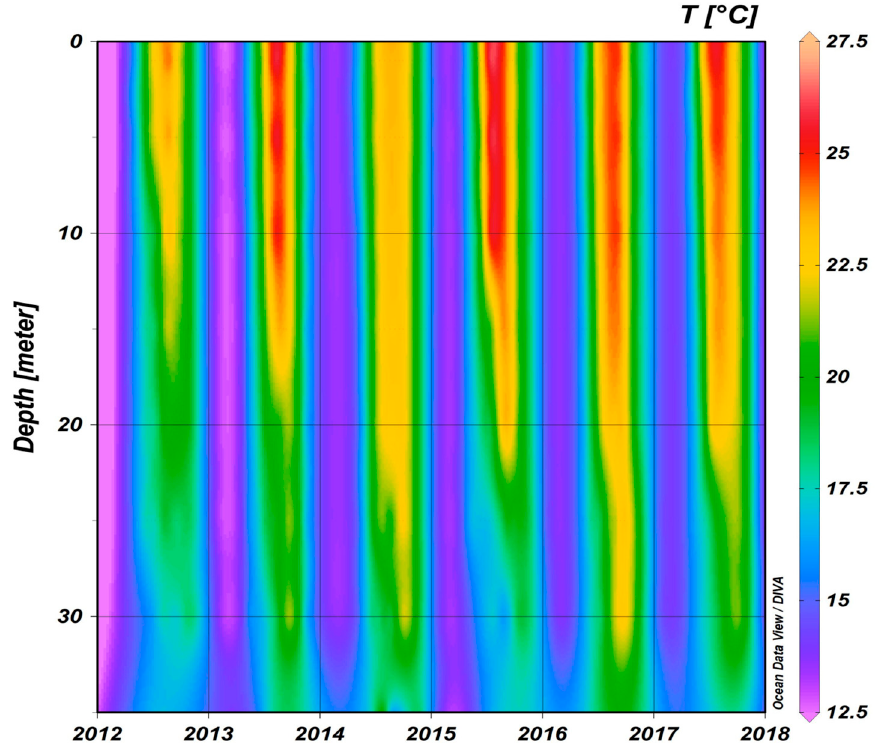
Figure 4. Stratification temperature maps showing the inter-annual variability of the temperature at the study site (the Calvi bay area) from March to September for the years from 2012 to 2017.